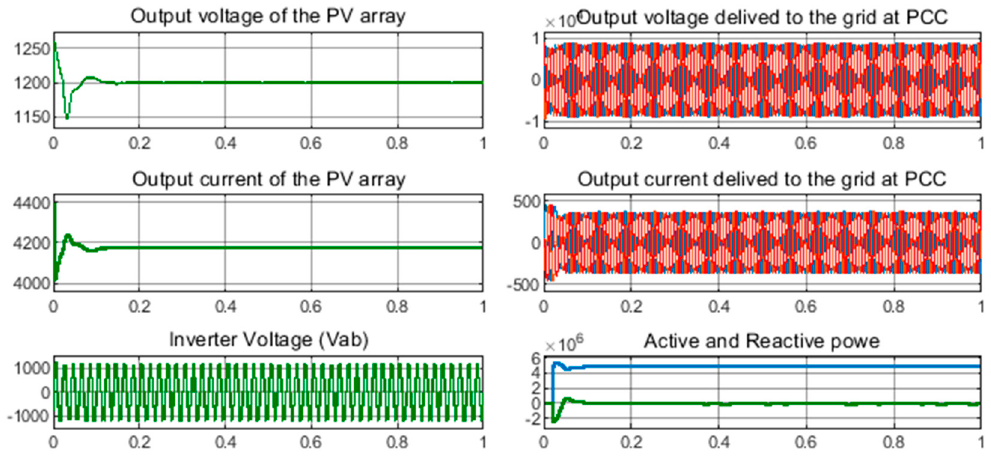
Figure 10. The output of the large scale grid-connected PV power plant.